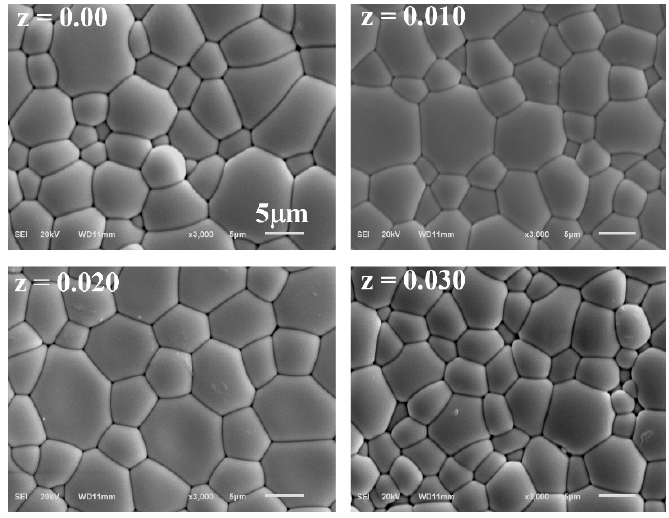
Figure 3. SEM micrographs of BFBT–zBCZT (z = 0.00–0.030) samples. The density of the ceramics is shown in Figure 4 at a sintering temperature of 1020 °C and a soaking time of 2 h. The unmodified ceramic sample had a density of 6.72 g/cm 3 , while the 2-mol.% modified sample showed an increased density value of 7.25 g/cm 3 (~96% densification), which began to drop at high dopant concentrations.